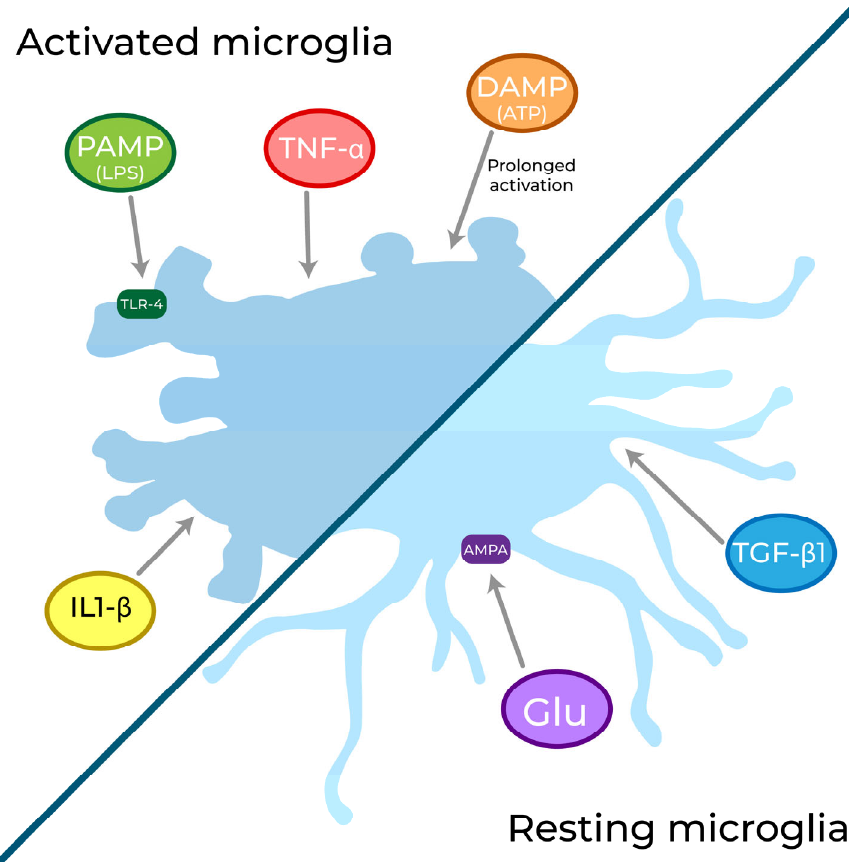
Figure 1. In the CNS, microglial cells are described as the most responsive to external cues. Based on the specific stimulus perceived, they can switch their phenotype from a resting one, characterized by a ramified morphology, to an activated ameboid-like one. Microglia can perceive a variety of the noxious stimuli, including DAMPs (like ATP) and PAMPs (like LPS), as well as pro-inflammatory cytokines like TNF- α and IL-1 β . In the resting state, microglia have been shown to express AMPA receptors for glutamate and both of the TGF- β 1 receptors that promote their ramified morphology. Concerning neural receptors, microglia express receptors able to respond to the most common neurotransmitters: D1–4 receptors for dopamine, 5-HT2 receptor for serotonin, α 1A, α 2A, β 1, and β 2 for adrenaline and noradrenaline, and the α 7 nicotinic receptor for acetylcholine [50]. Moreover, they are able to sense bradykinin, endothelin, angiotensin, somatostatin, opioid, neurotrophins, neuropeptides, thrombin, cysteinyl leukotrienes, Notch-1, macrophage colony-stimulating factor, formyl peptide, and lysophosphatidic acid [50]. When considering the pathophysiology of neurodegenerative disorders, glu- tamate receptors in microglial cells should be considered a primary pharmacological target for their role in excitotoxicity and glutamate clearance under the control of mi- croglia [51]. Glutamate is mainly uptaken by microglia and astrocytes and released through HCs [52]. Among ionotropic glutamatergic receptors, all of the four α -amino-3-hydroxy- 5-methyl-4-isoxazolepropionic acid (AMPA) receptor types [53], three of the kainate fam- ily [54] and N -methyl-D-aspartate (NMDA) are expressed in microglia [55]. On the other hand, metabotropic glutamate receptors belonging to Group I (e.g., mGluR5), Group II (mGluR2,3), and Group III (mGluR4,6,8) coupled to cAMP and regulating tumour necrosis factor- α (TNF- α ) release are also strongly expressed [56,57]. Furthermore, receptors for γ -amino butyric acid (GABA) can be found on microglial membranes and play a role in calcium ions (Ca 2+ ) signalling and the regulation of K + channels